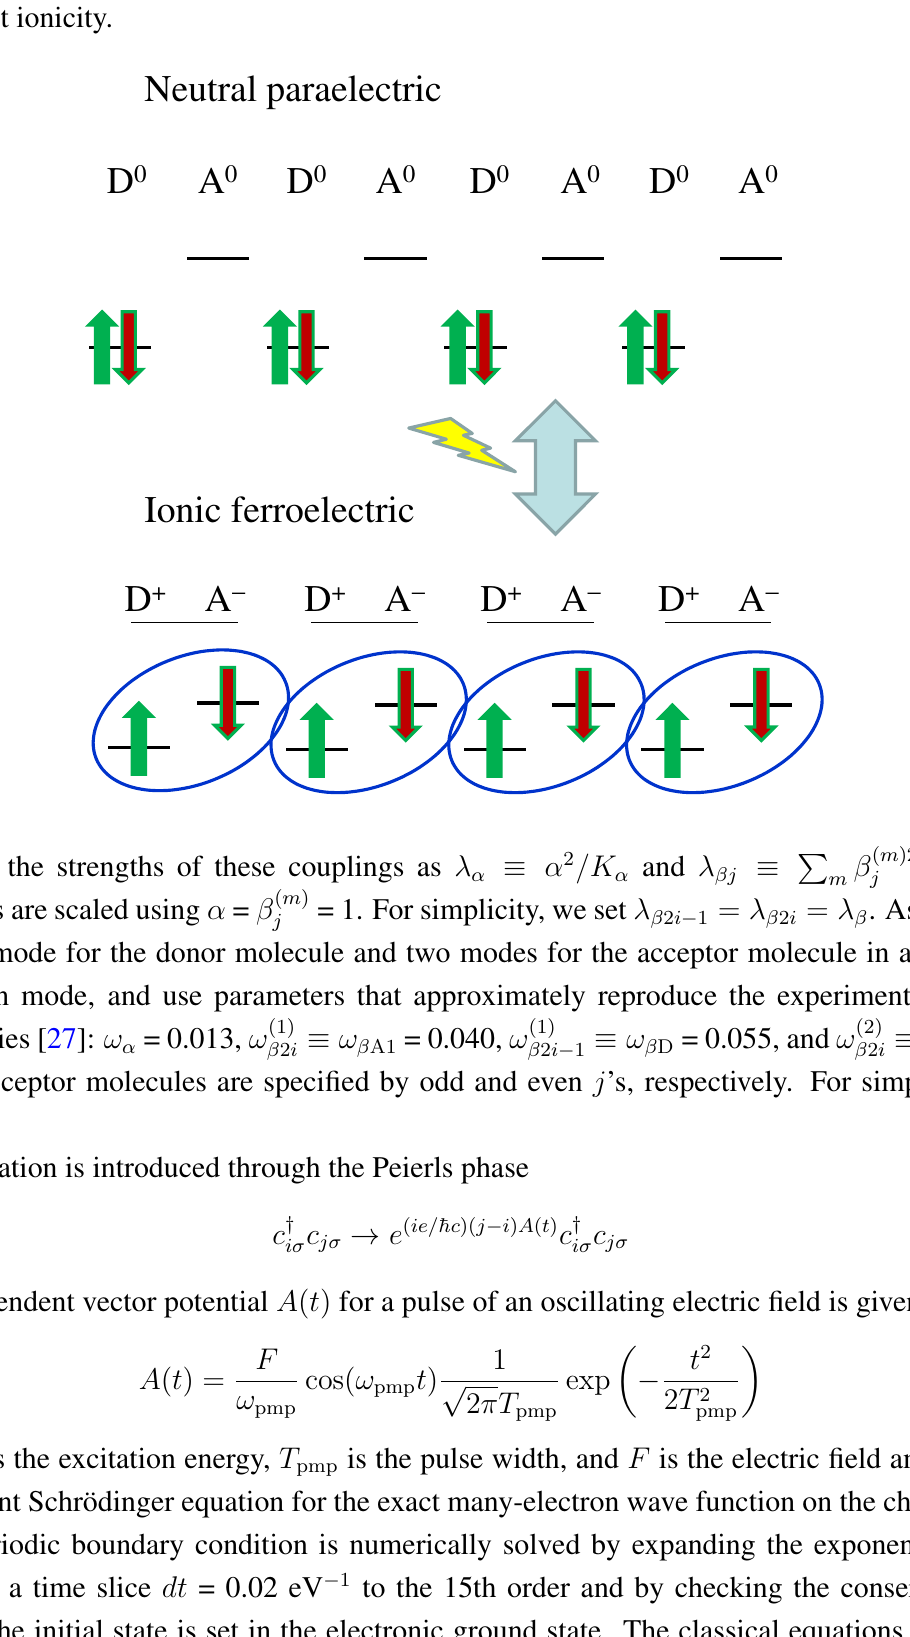
Figure 1. Schematic electronic and lattice structures of TTF-CA. Photoexcitation creates transient